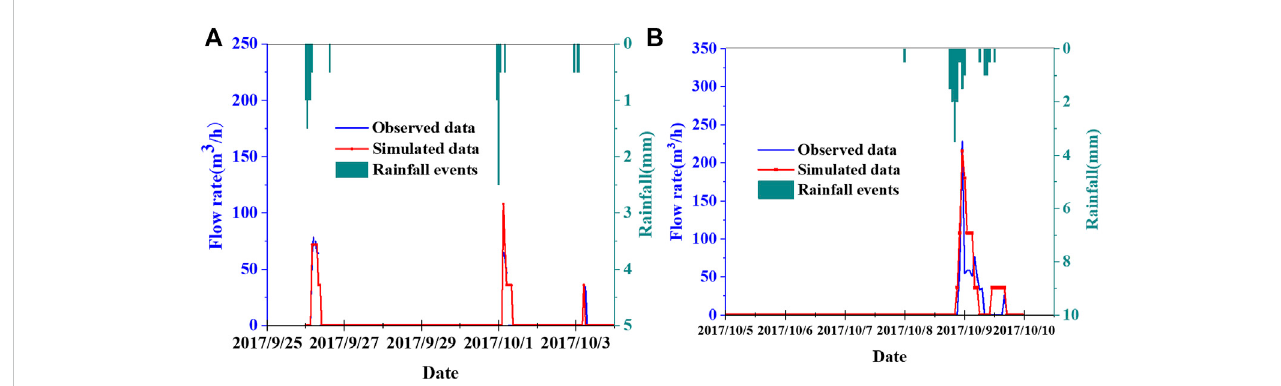
FIGURE 6 Comparison between measured and simulated data. (A) Calibration period, (B) Validation